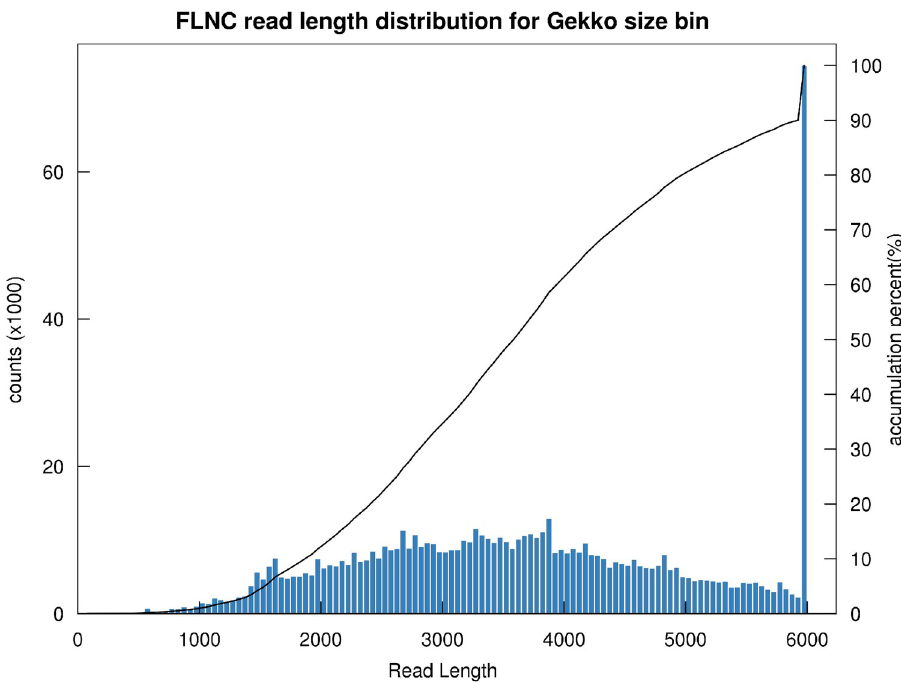
Fig 1. Distribution of the FLNC read